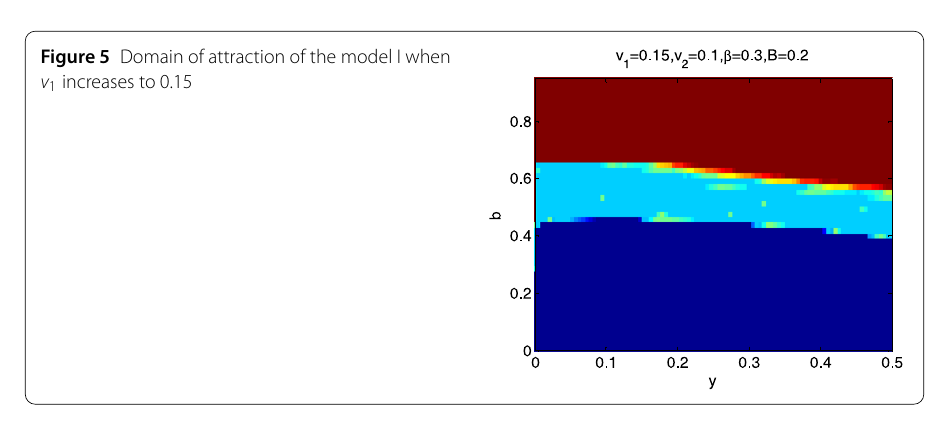
Figure 6 Domain of attraction of the model I when